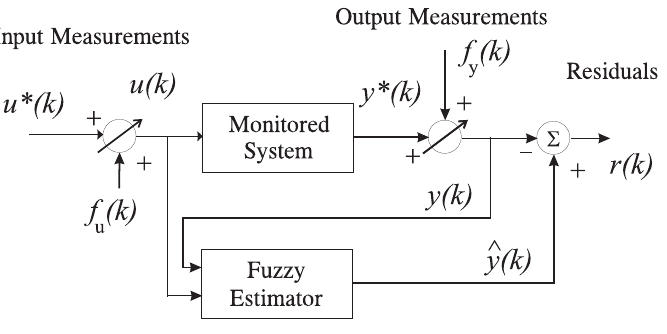
Figure 2. The residual generation